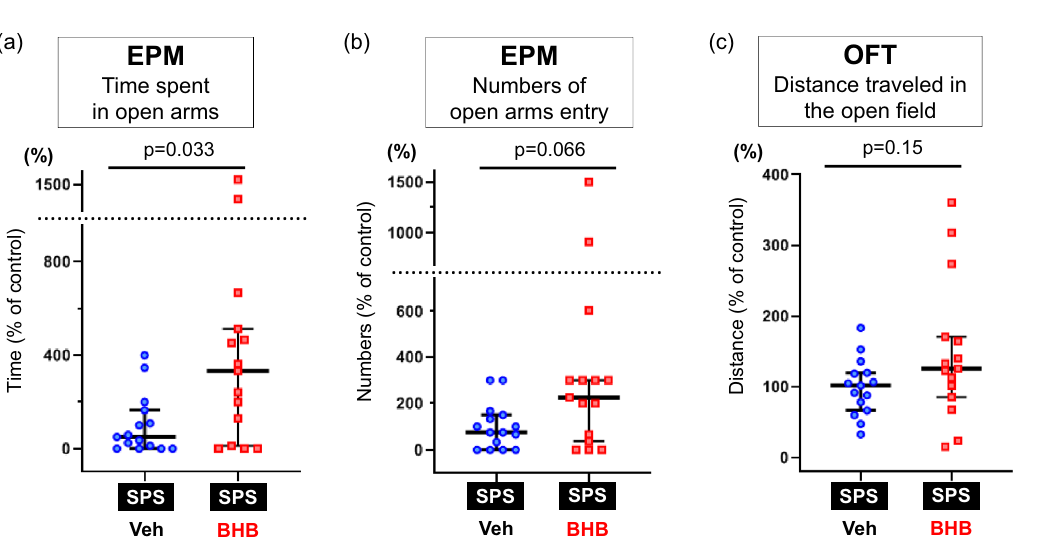
Figure 3. BHB treatment attenuates SPS-induced anxiety-like behavior. ( a ) The time spent in the open arms of the EPM is shown. Rats exposed to BHB had significantly increased time spent in the open arms of the EPM in SPS-induced PTSD rats (median [IQR]; SPS + Veh: 50.0 [6.3–136.5], SPS + BHB: 333.3 [70.5–489.6], Mann–Whitney’s U-test; W = 61.5, p = 0.033). ( b ) Number of open-arm entries in the EPM are shown. BHB tended to increase the number of open-arm entries in SPS-induced PTSD rats (median [IQR]; SPS + Veh: 75.0 [16.7–141.7], SPS + BHB: 225.0 [52.1–300.0], Mann–Whitney’s U-test; W = 68.5, p = 0.066). ( c ) Distance traveled in the OFT is shown and was unchanged after BHB treatment (median [IQR]; SPS + Veh: 101.7 [72.5–119.2], SPS + BHB: 125.9 [93.6–167.6], Mann–Whitney’s U-test; W = 77, p = 0.15). Data are shown using % of controls. Reference control is the SPS + Veh group. The data are presented as scatter plots including median and interquartile range. Mann–Whitney’s U-test was performed to compare two groups. n = 15/group. EPM: elevated plus maze test, OFT: open field test, SPS: single prolonged stress, Veh: Vehicle (PBS), BHB: beta- hydroxybutyrate, n = 15 The data are presented as scatter plots including median and interquartile